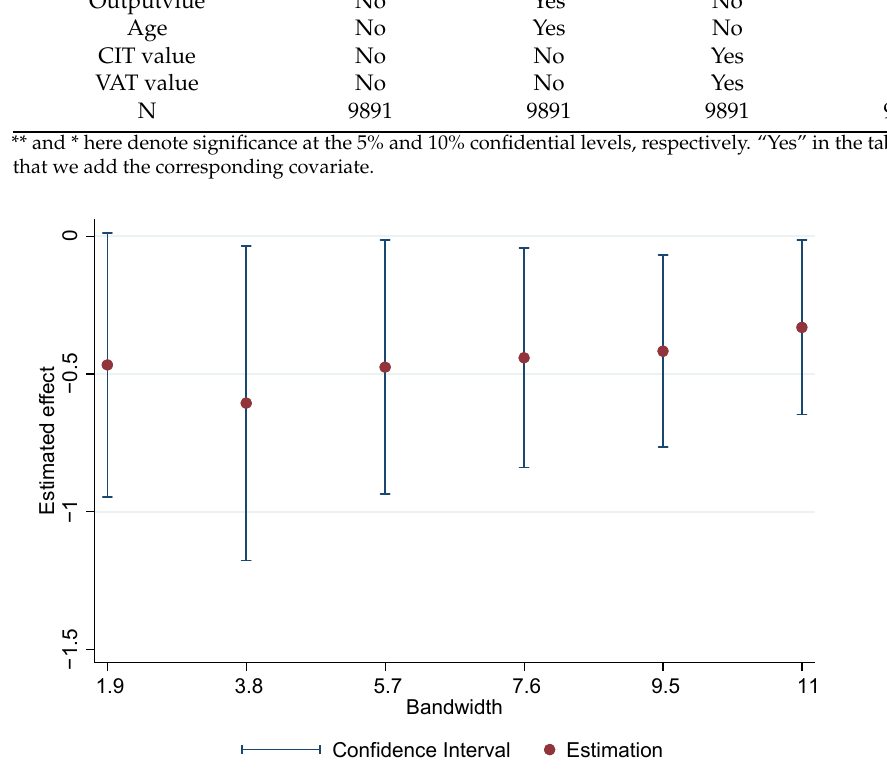
Table 3. Mechanism: Impact of the reform on the effective tax rates and land prices by using 2SLS.